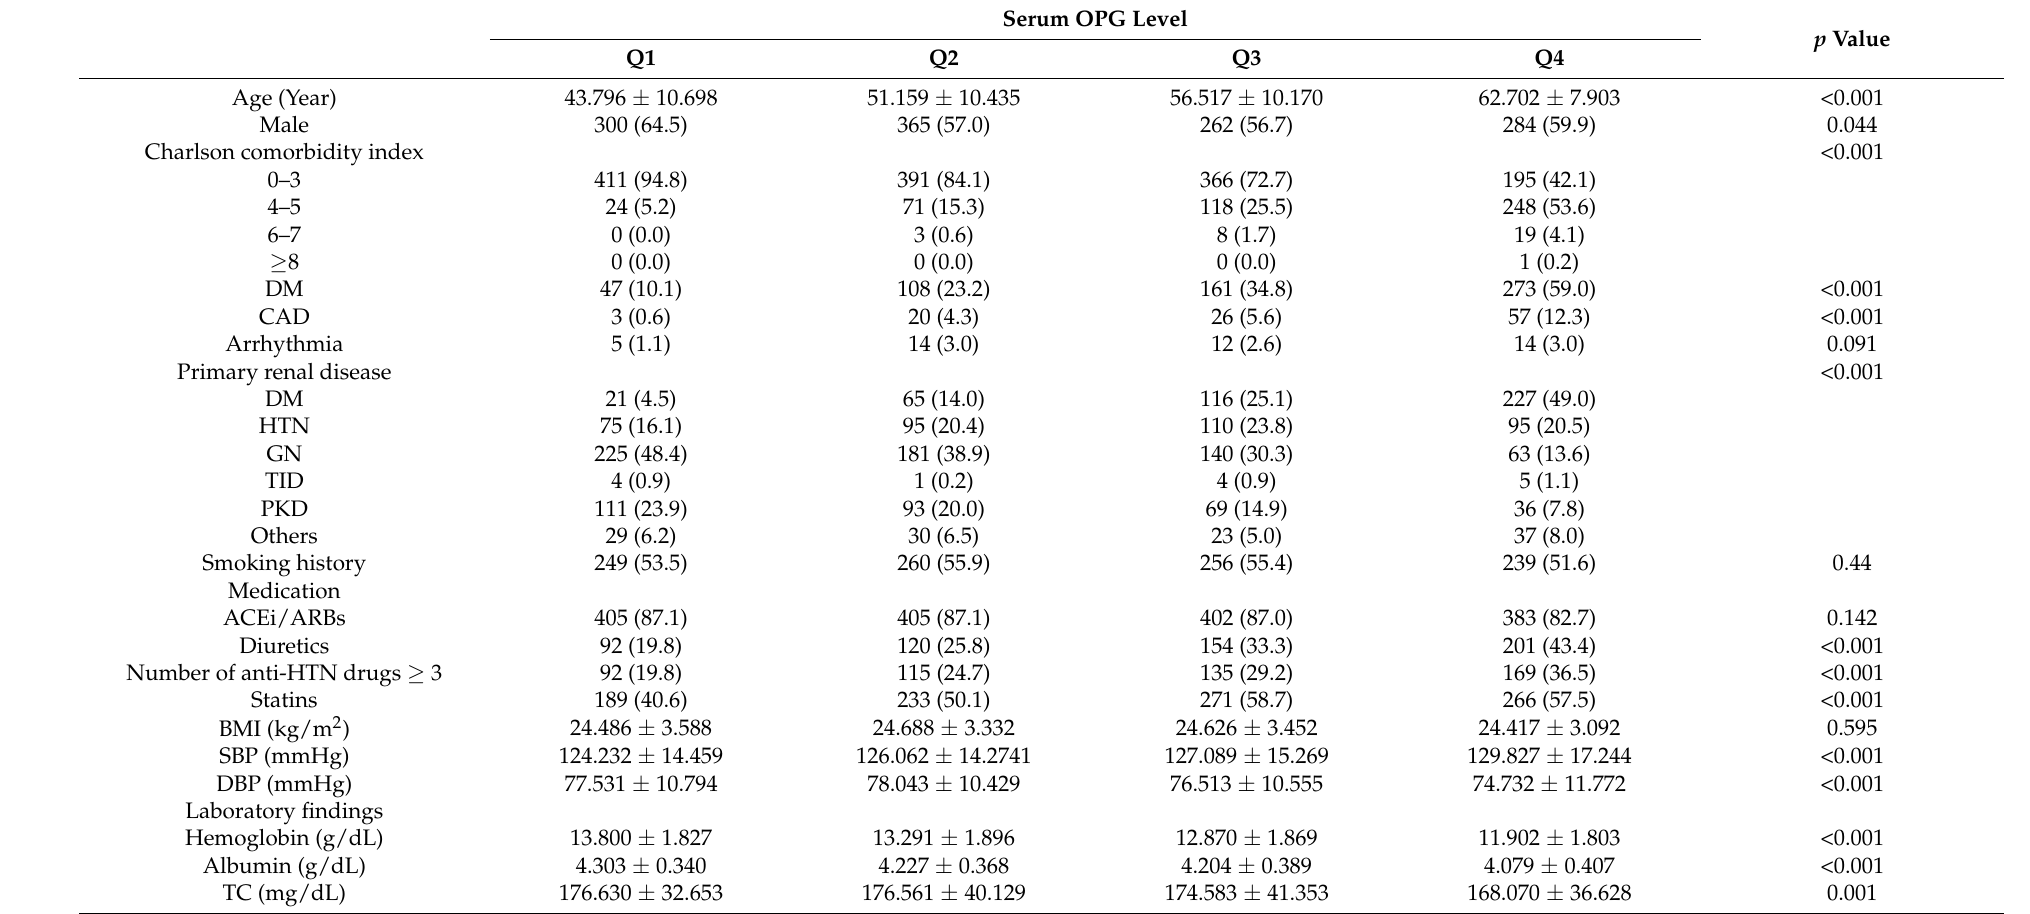
Table 1. Baseline characteristics of study participants by serum OPG